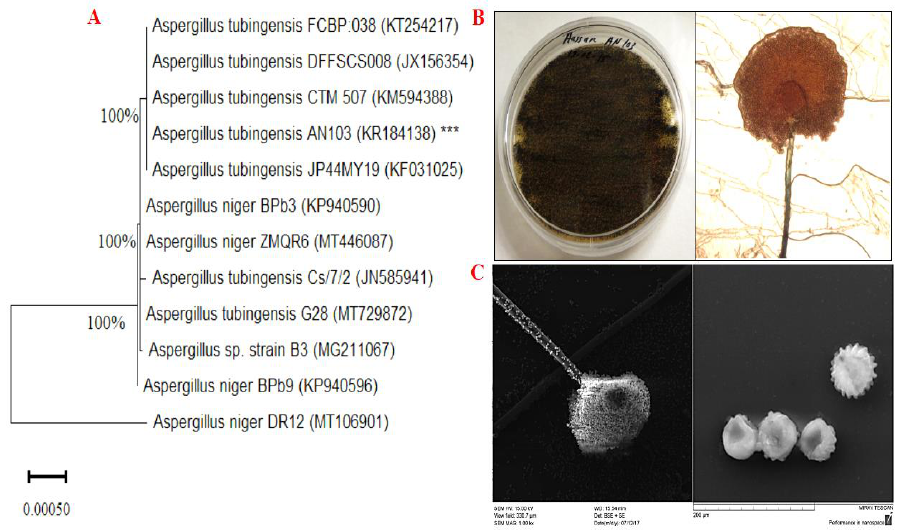
Figure 1. ( A ) The neighbor-joining (NJ) phylogenetic tree based on ITS gene sequences of AN103, with closely related strains accessed from the GenBank using BLASTN tool. These sequences were aligned using ClustalW. Bootstrap values included 500 replicates for the NJ method using MEGA software (version 11.0.6). *** indicates selected strain. ( B ) Morphological features of AN103 strain on agar plates. ( C ) Spore and sporangium of AN103 strain under SEM.